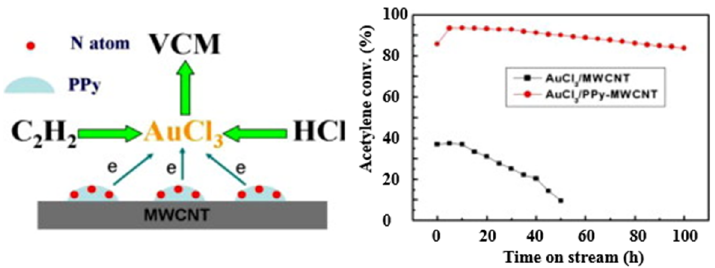
Figure 6. AuCl 3 /PPy–multiwall carbon nanotube (MWCNT) catalyst for acetylene hydrochlorination [66].